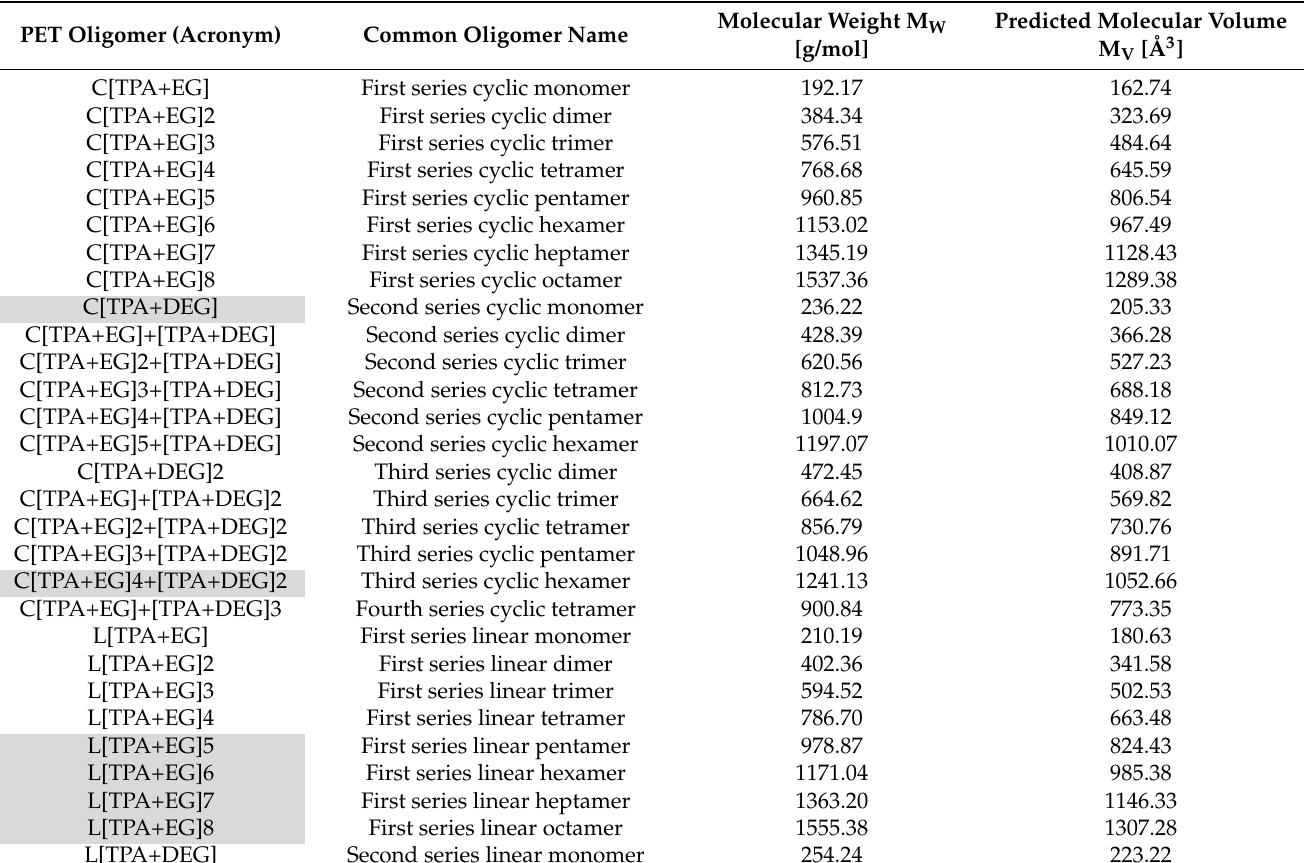
Table 1. Summary of reported PET oligomers and hypothetical molecules. PET oligomer names (acronyms) of the hypothetical PET oligomers are highlighted in